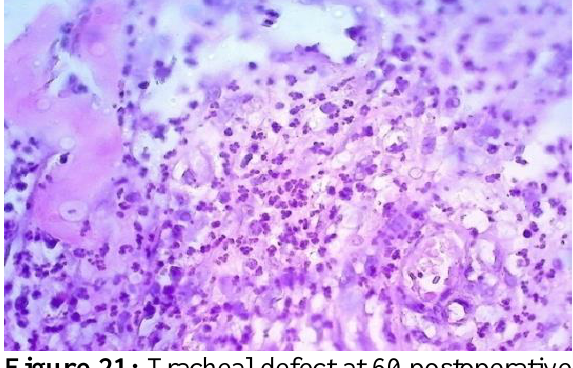
Figure 21: Tracheal defect at 60 postoperative day in G2 infiltration of mononuclear inflammatory cells (A) and (giant cells (B) (H&EX40).